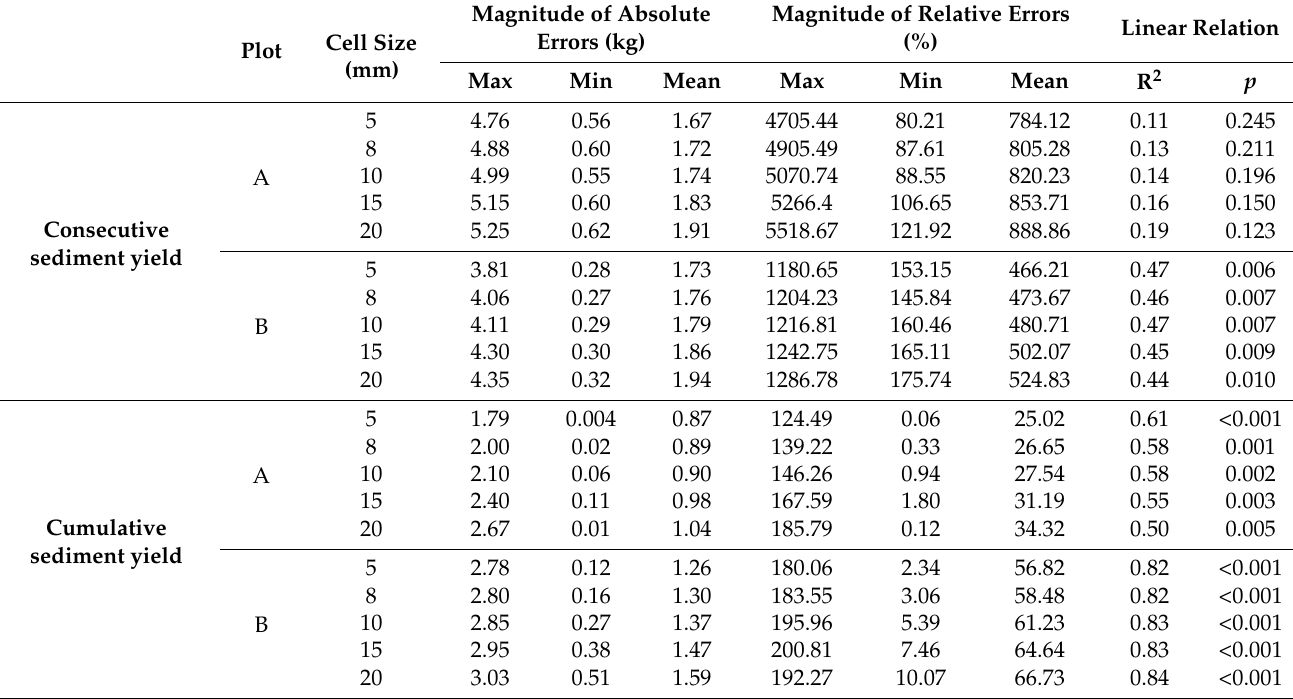
Table 1. The magnitude of absolute errors and relative errors for the calculated sediment yields of hillslopes and quality of the linear regression between the calculated and measured sediment yields for the 14 experiments under the 5 mm–20 mm grid-cell